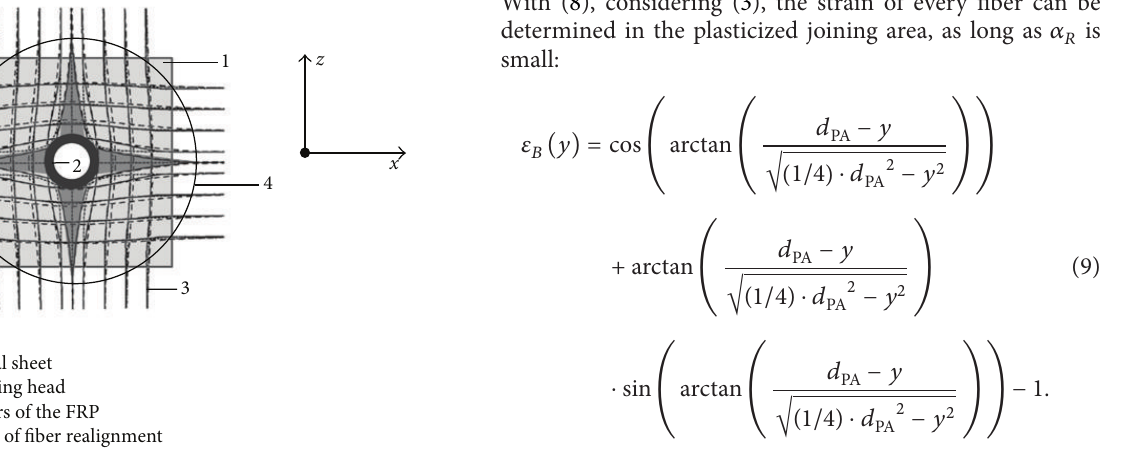
Figure 4: Schematic view of realigned fibers at the joint of an orthotropic